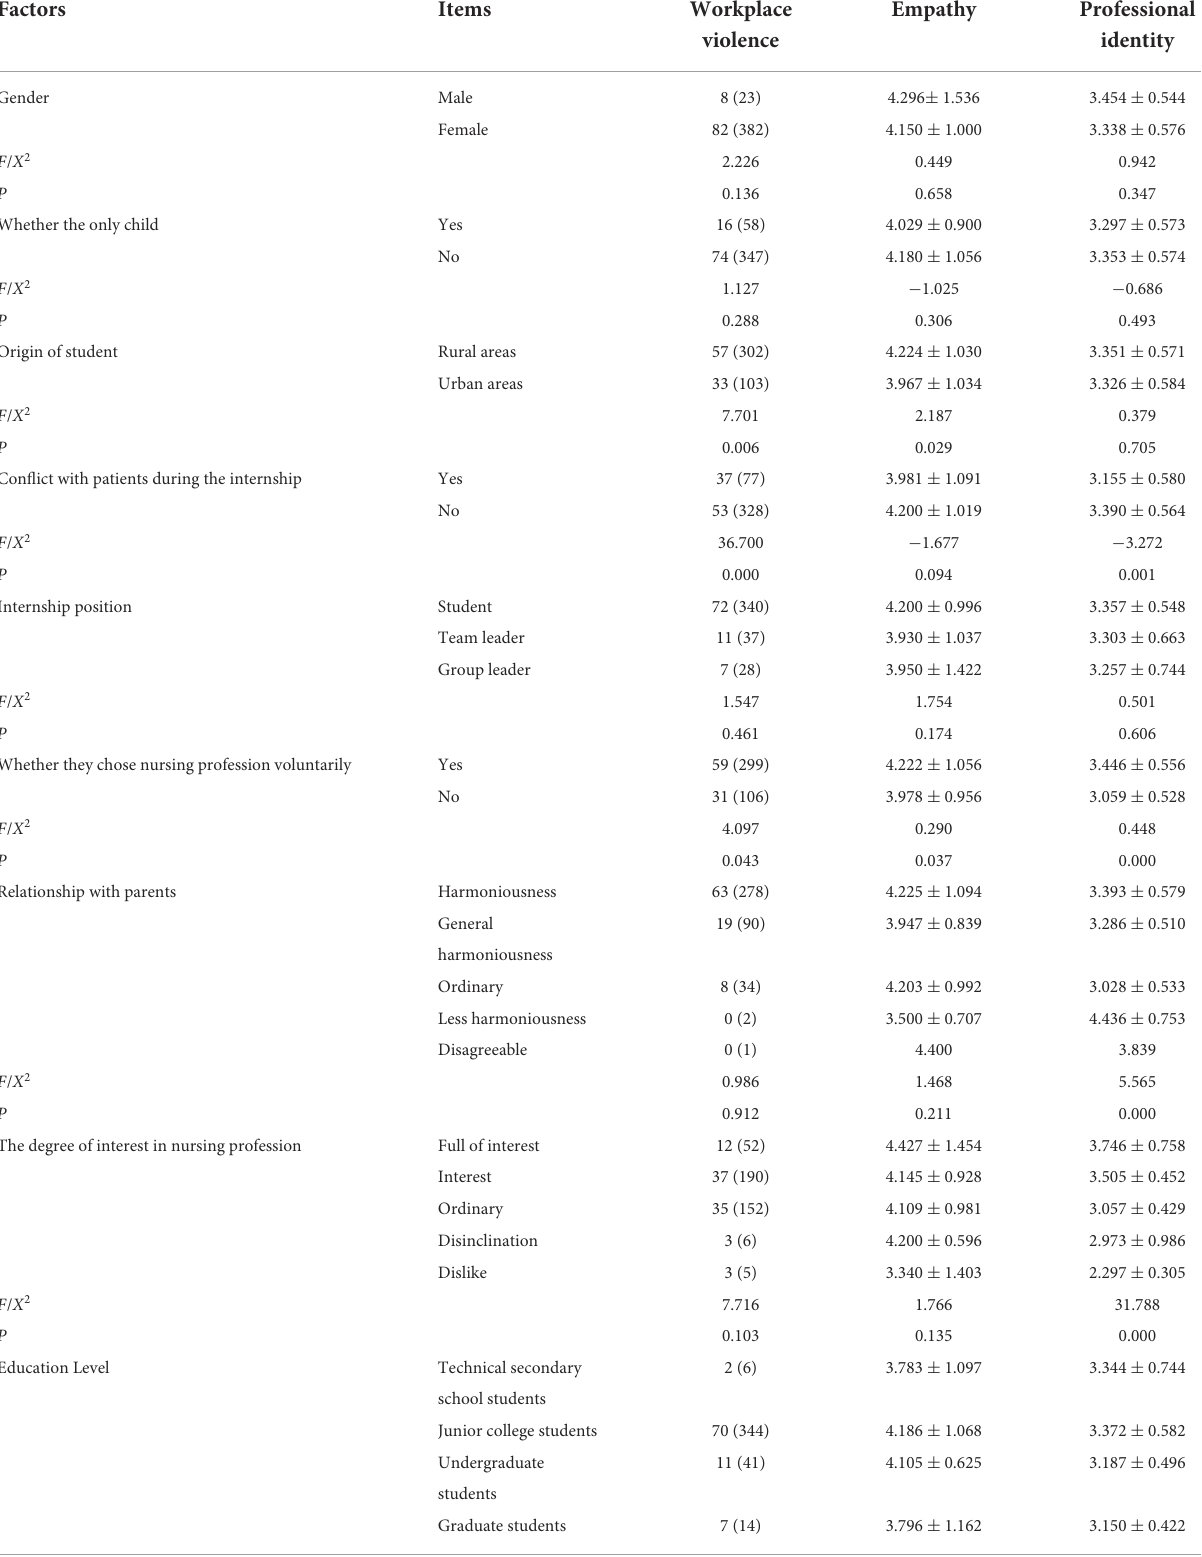
TABLE 1 Scores on workplace violence, empathy, and professional identity of nursing students of different characteristics. Factors Items Workplace